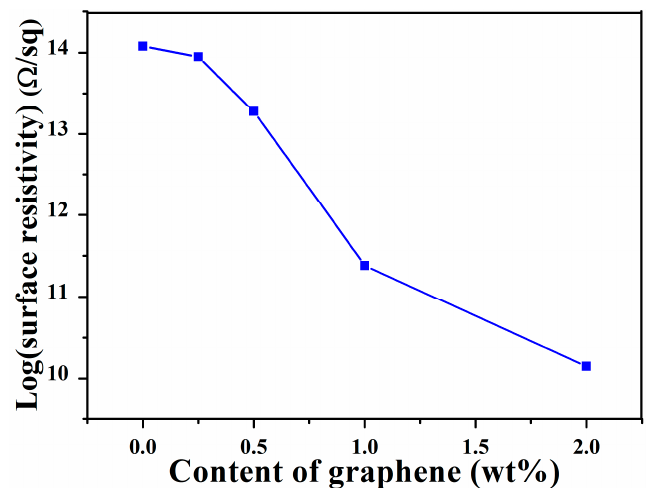
Figure 5. Surface resistivity of SIS and graphene/SIS composites.